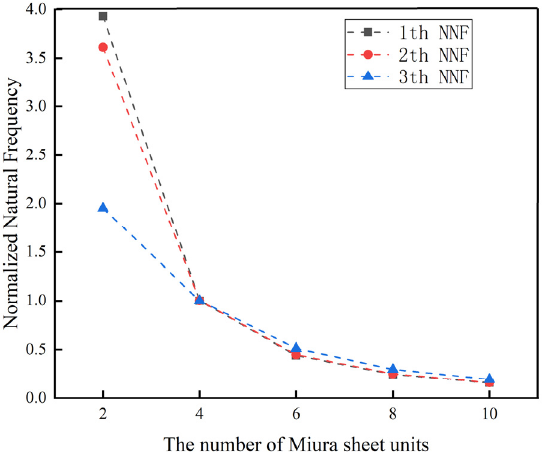
Figure 8. Numerical simulation results of the NNF of the Miura tube when the number of arrange- ments of Miura sheet units varied.